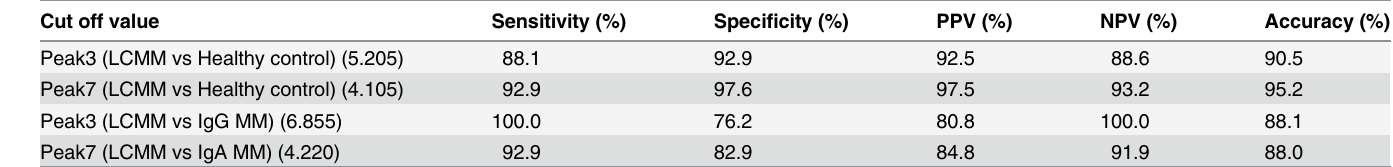
Table 4. Sensitivity and specificity of N-glycan biomarkers for the diagnosis and differential diagnosis of LCMM. Cut off